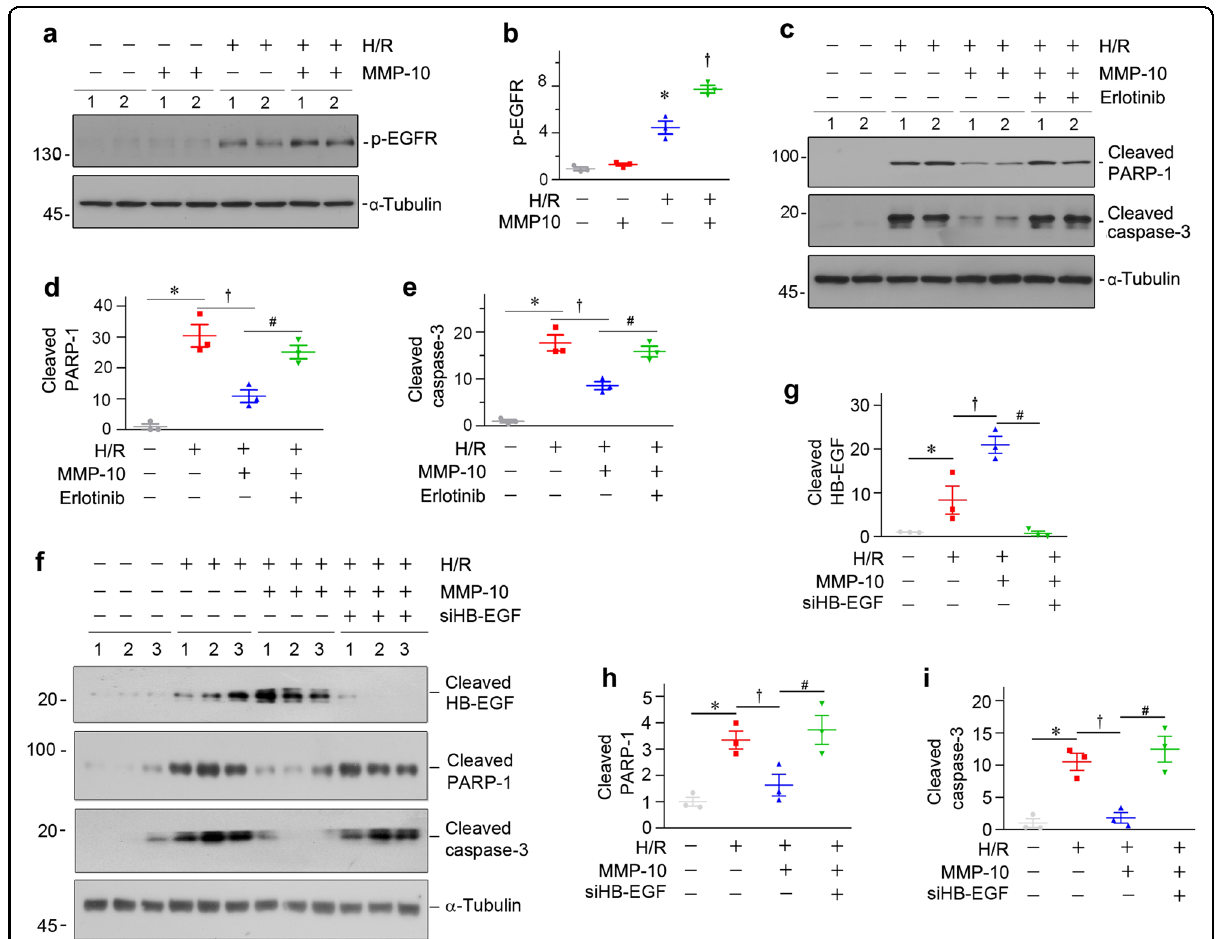
Fig. 7 MMP-10 promotes tubular cell survival through augmenting EGFR signaling in vitro. a Representative western blots show protein expression of p-EGFR after various treatments in HKC-8 cells. b Graphic presentations show the relative abundances of p-EGFR in different groups as indicated. * P < 0.05 versus control cells; † P < 0.05 versus H/R alone ( n = 3). c Representative Western blots show protein expression of cleaved PARP-1 and cleaved caspase-3 after various treatments in HKC-8 cells. d , e Graphic presentations show the relative abundances of cleaved PARP-1 ( d ) and cleaved caspase-3 ( e ) proteins in different groups as indicated. * P < 0.05 versus control cells; † P < 0.05 versus H/R alone; # P < 0.05 versus H/R with MMP-10 ( n = 3). f – i Knockdown of HB-EGF by siRNA abolishes MMP-10-mediated protection of tubular epithelial cells against apoptosis induced by hypoxia/reoxygenation (H/R). Western blots ( f ) and quantitative data show protein expression of cleaved HB-EGF ( g ), cleaved PARP-1 ( h ), and cleaved caspase-3 ( i ) after various treatments as indicated in HKC-8